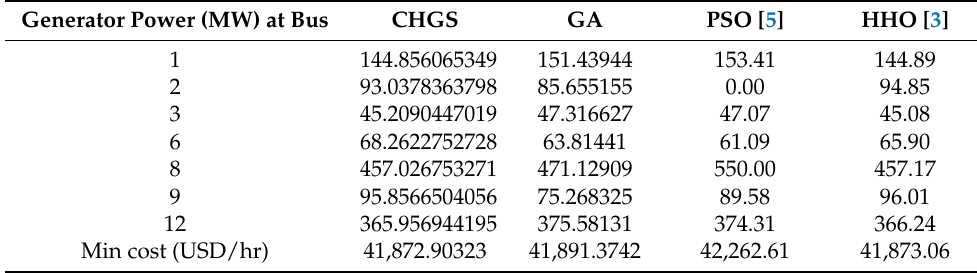
Table 2. Optimal cost and design variables for the 57-bus system.